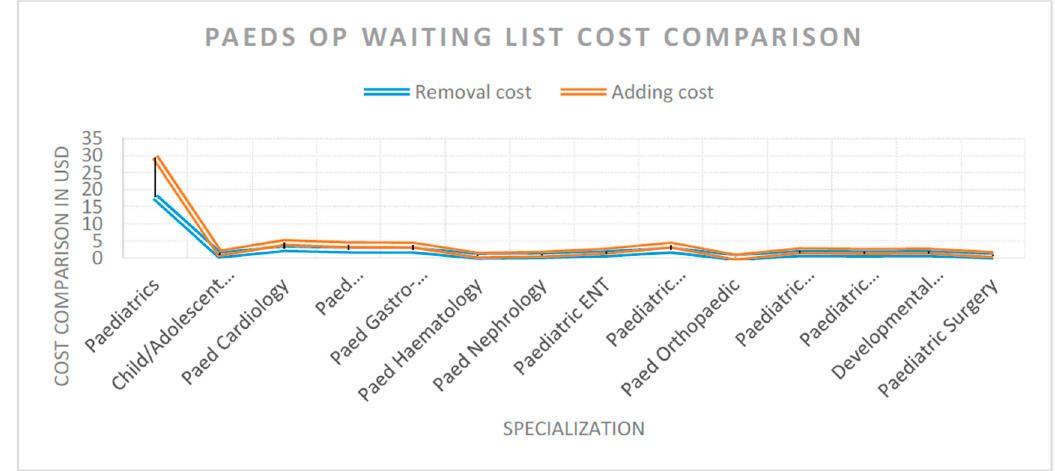
Figure 17. Cost comparison among different smart contracts and entities.